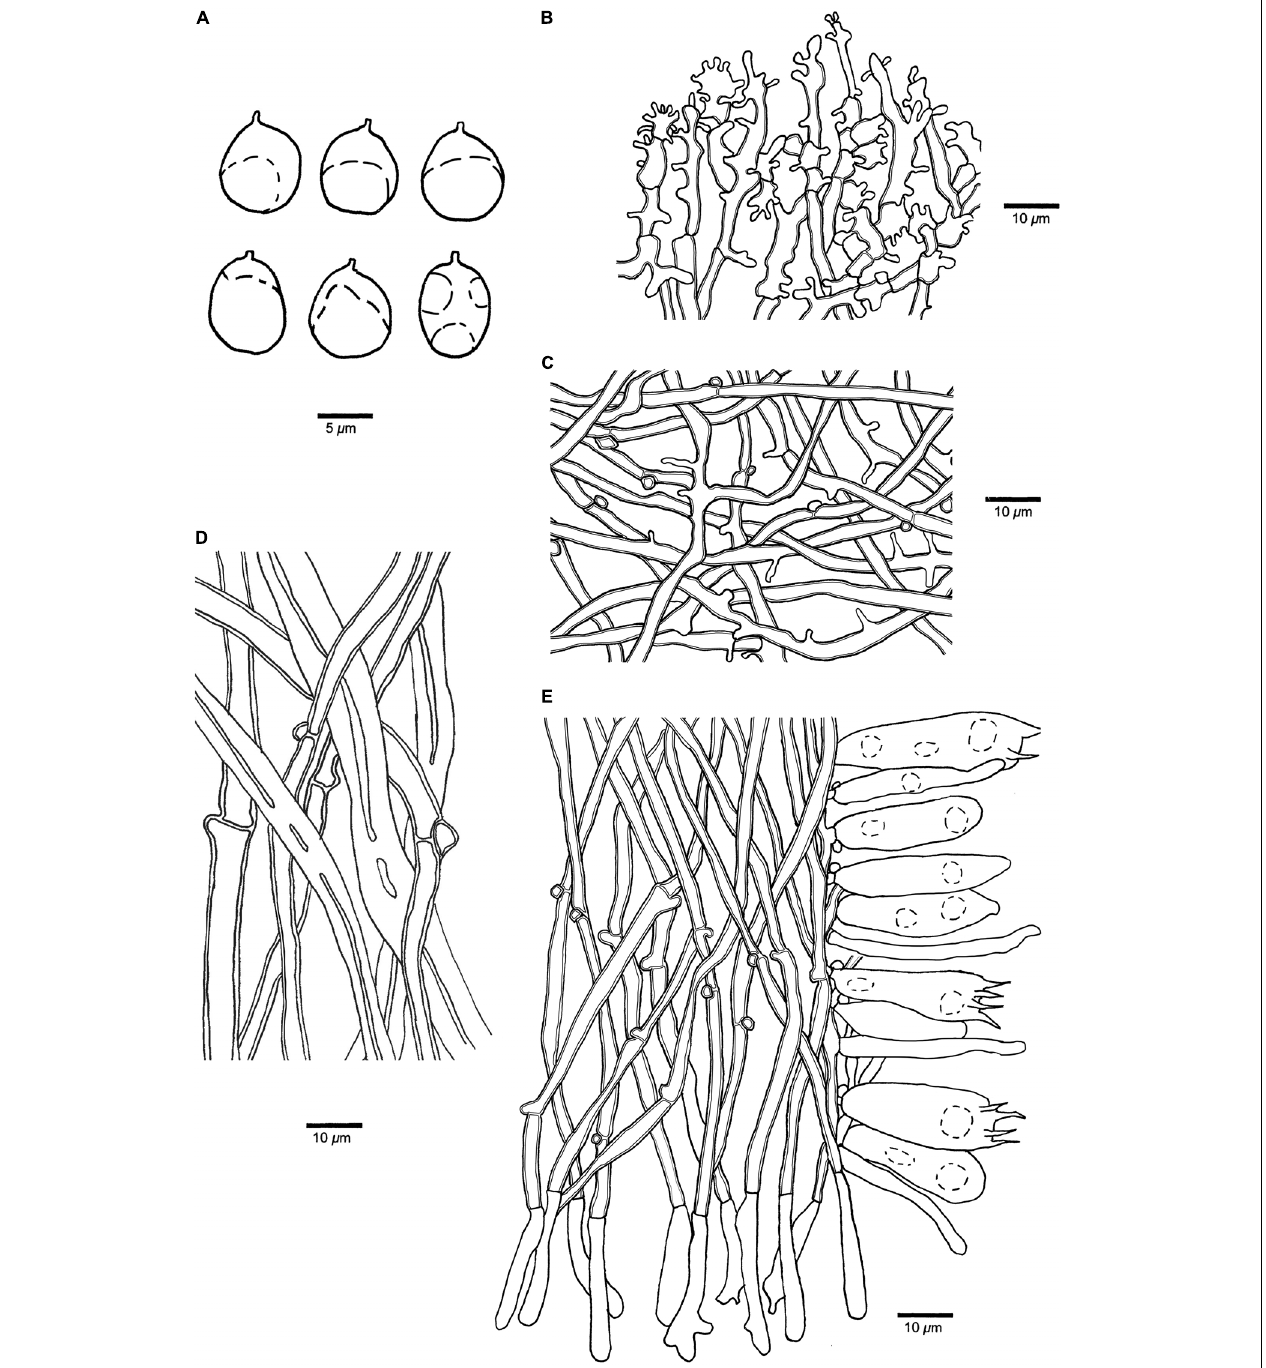
FIGURE 6 | Microscopic structures of Panellus crassiporus (holotype). (A) Basidiospores. (B) Dichophysial hyphae from pileipellis. (C) Hyphae from pileus. (D) Hyphae from stipe. (E) A section of tube trama, including pleurocystidia, cheilocystidia, basidia, and basidioles. The dotted circles represent some guttules in basidiospores, basidia or basidioles.